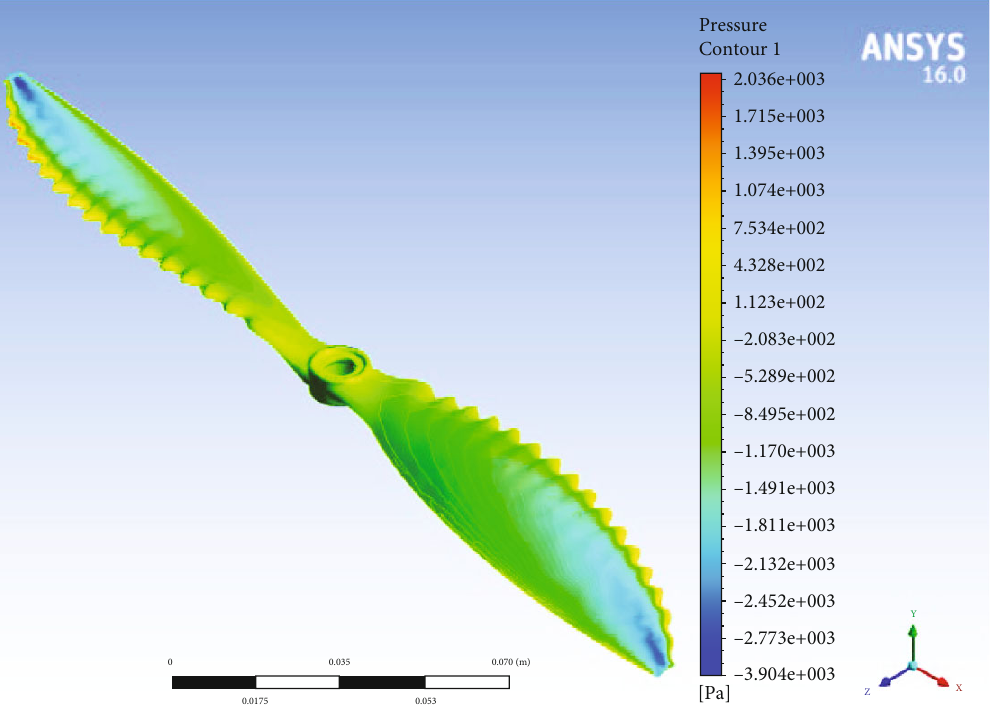
Figure 26: Pressure contour at -50 ° C